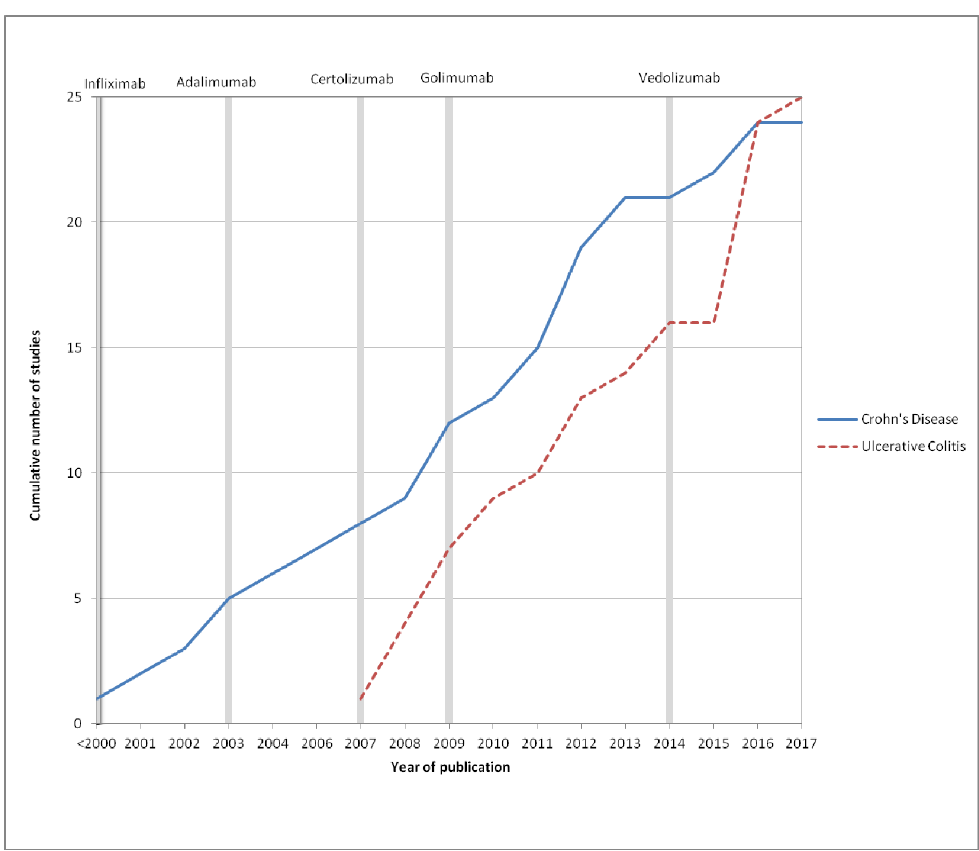
Fig 2. Frequency of published economic evaluations on Crohn’s disease and ulcerative colitis over time; grey bars indicate year of marketapproval by the European Medicines Agency (EMA).